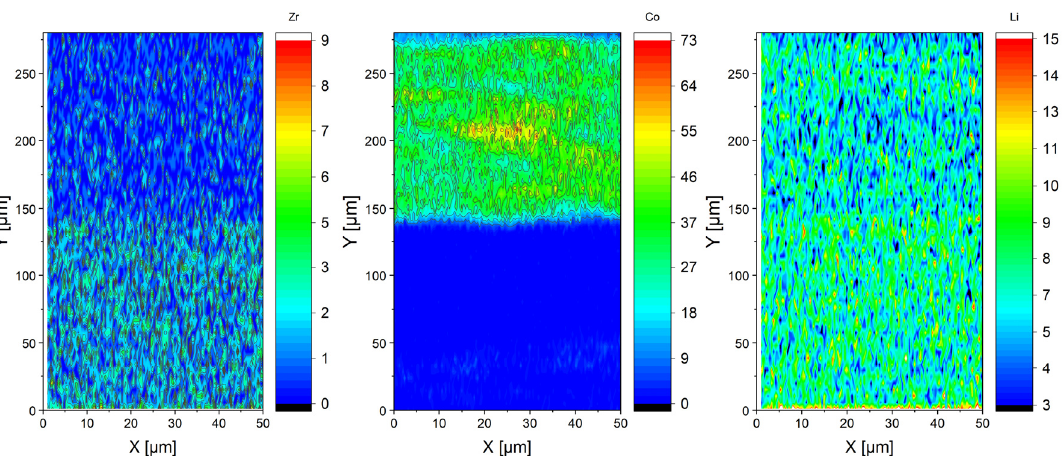
Figure 1. Exemplary 2D elemental maps of the spatial distribution of element specific counts of the three major elements of the LLZ-based cell charged to 4.2 V. The maps show the LCO + LLZO part at Y = 150–280 µm and the LLZ separator at Y = 0–150 µm.